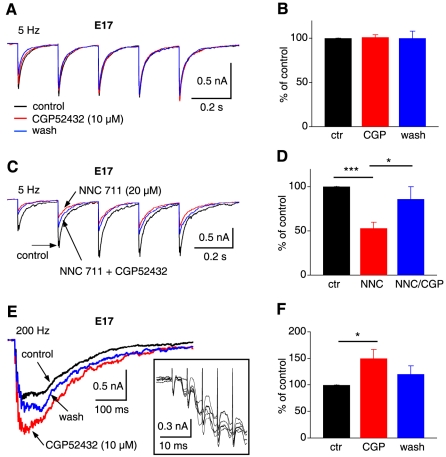
Endogenous activity of GABABRs is stimulus frequency dependent.
A, Average IPSC traces of one NL neuron (E16–17) in response to train stimulations at 5 Hz (5 pulses) under the conditions of control, GABABR antagonist CGP52432 (10 µM), and washout. B, IPSC peak amplitude normalized to the control showed that CGP52432 did not have significant effects on the IPSCs elicited at 5 Hz (n = 7), indicating lack of endogenous GABABR activity under this stimulation condition. C & D, Blocking GABA uptake by NNC 711 (20 µM) reduced IPSCs elicited at 5 Hz. In the presence of NNC 711, CGP52432 (10 µM) increased IPSC amplitude significantly (n = 7), revealing endogenous GABABR activity. E & F, In response to blockade of GABABRs by CGP52432 (10 µM), a significant increase in IPSC amplitude was observed at the stimulus frequency of 200 Hz (n = 8). The inset in panel E shows six superimposed individual IPSCs obtained under control conditions, at enlarged scales. Only the responses to the first five stimulus pulses (without blanking the stimulus artifacts) are shown to indicate low noise levels of the recordings.